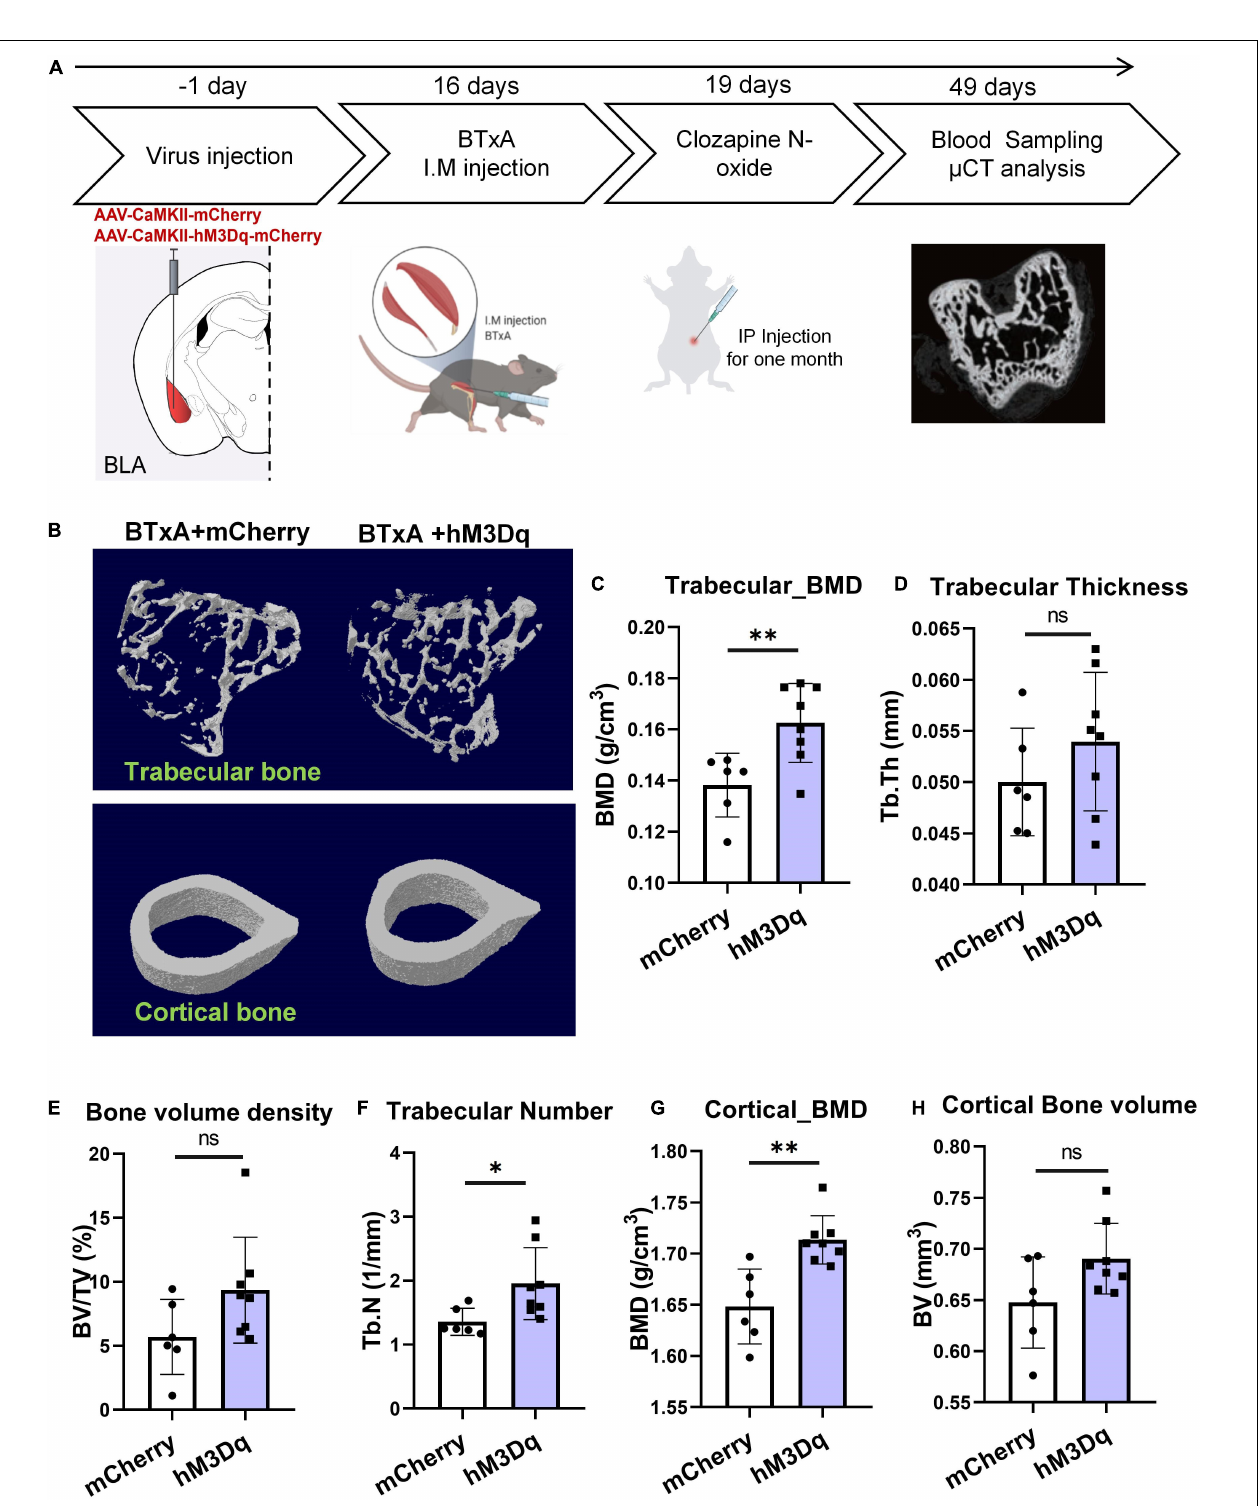
FIGURE 4 | Chemogenetic manipulation of BLA CaMKII neurons ameliorates severe bone loss induced by muscle dysfunction. (A) Experimental procedure of chemogenetic stimulation after muscle dysfunction induced by BTxA treatment. (B) Representative µ CT images of trabecular and cortical bones. (C–H) Quantitative analysis of µ CT images of bone parameters. (C) Trabecular BMD, (D) trabecular thickness, (E) trabecular volume fraction, (F) trabecular number, (G) cortical BMD, and (H) cortical bone volume. N = 6 (mCherry group), N = 8 (hM3Dq group). ∗ P < 0.05, ∗∗ P < 0.01, ns means not significant. All data represent mean ± SD; statistical analysis was assessed using Student t -test for panels (C–H)